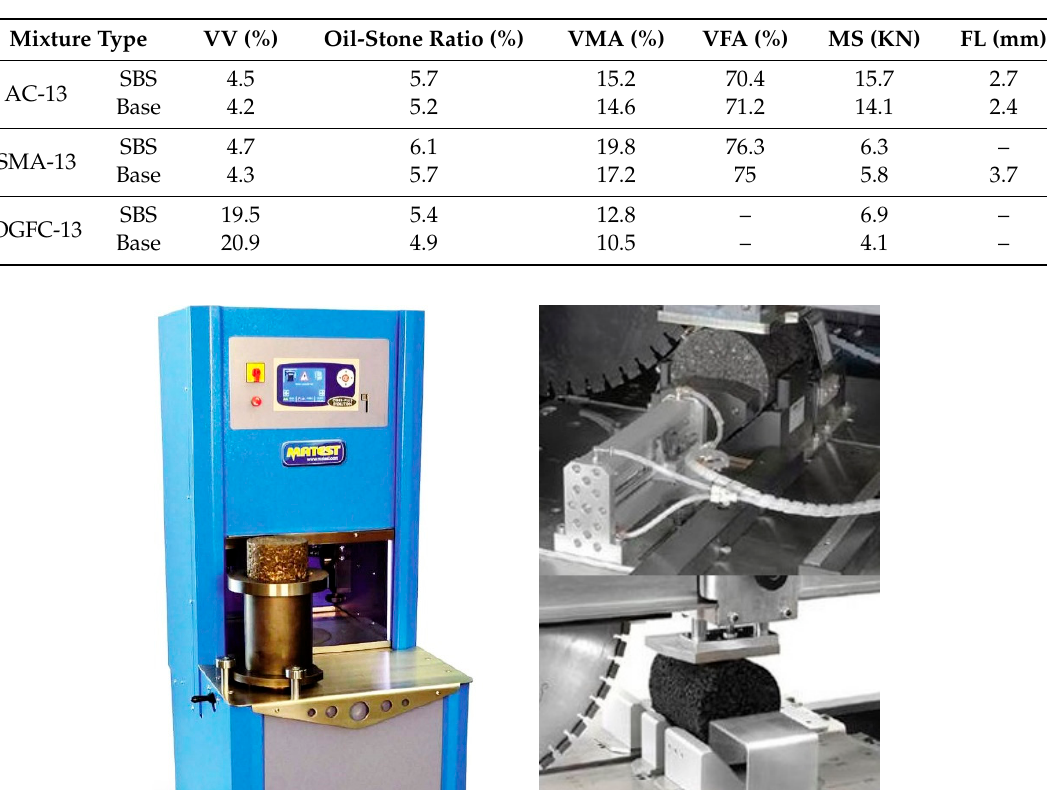
Table 3. The Marshall test results.